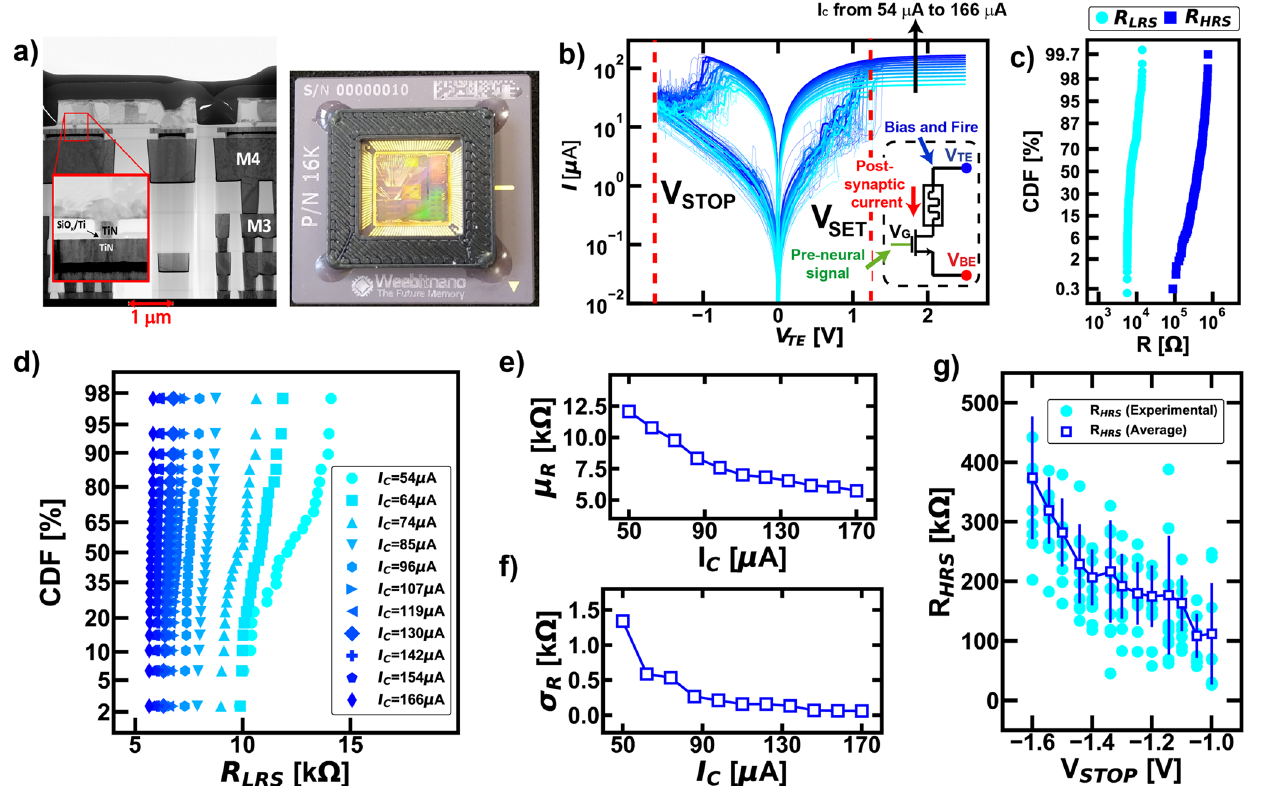
Fig. 1 | Electrical characterization of the RRAM synaptic devices. a Scanning Electron Microscope image of the SiO x RRAM devices and sample photo of the packaged RRAM arrays used in this work. b I-V characteristics of the 1T1R RRAM devices (device-to-device measurements) at fi xed V STOP as a function of the com- pliancecurrentI C inordertostudytheswitchingmechanismofthesynapsesunder different operative conditions. Note that the compliance current is directly man- aged by acting on the gate voltage V G of the selector of the cell, which is an nmos transistor.Bysendingpre-neuronalspikesatthegateoftheselectorandbiasingthe top electrode of the RRAM synaptic element, a post-synaptic current is generated